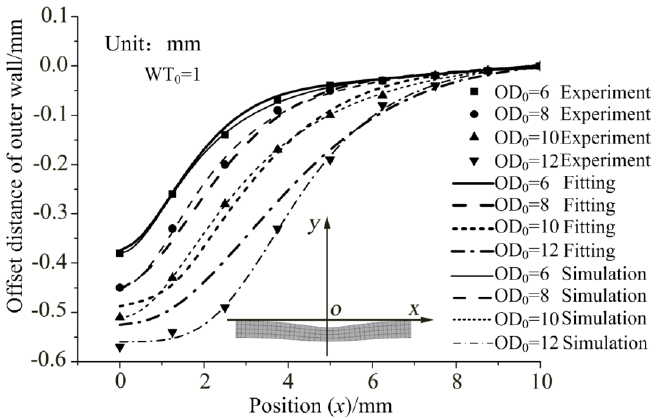
Figure 7. Inner wall profiles at fracture from tensile test and simulation results and the logistic regression fitted curves in different outer diameters. Table 2. Fitted parameters of the logistic regression model for OD 0 = 6mm tubes with different WT 0 . Wall Thickness (mm)